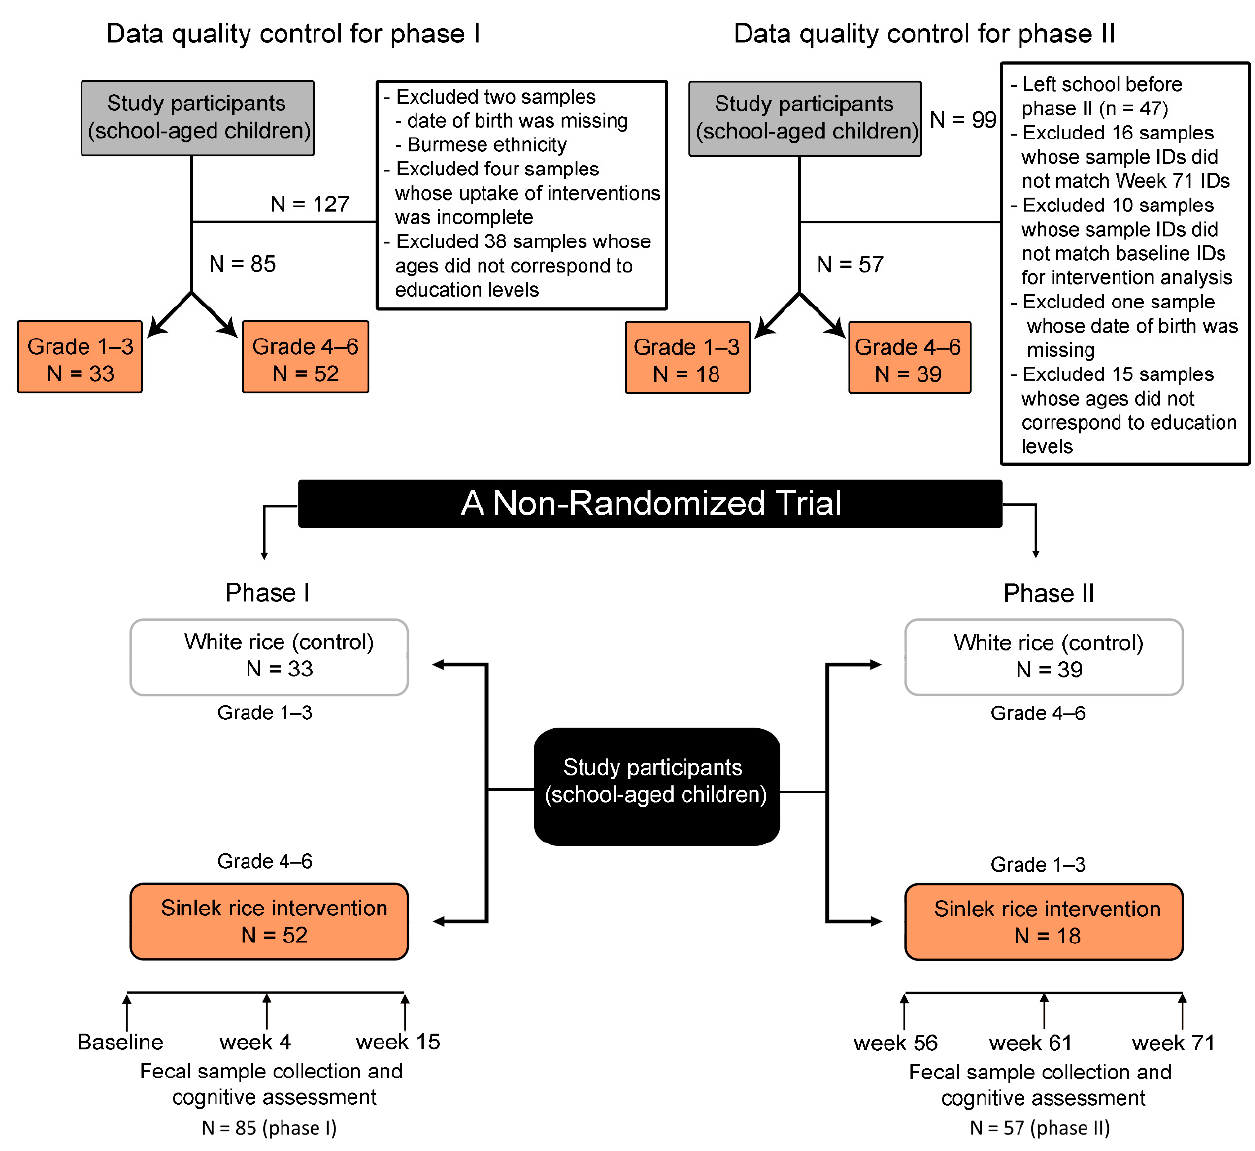
Figure 1. Progress of participants (school-aged children) through the non-randomized trial.